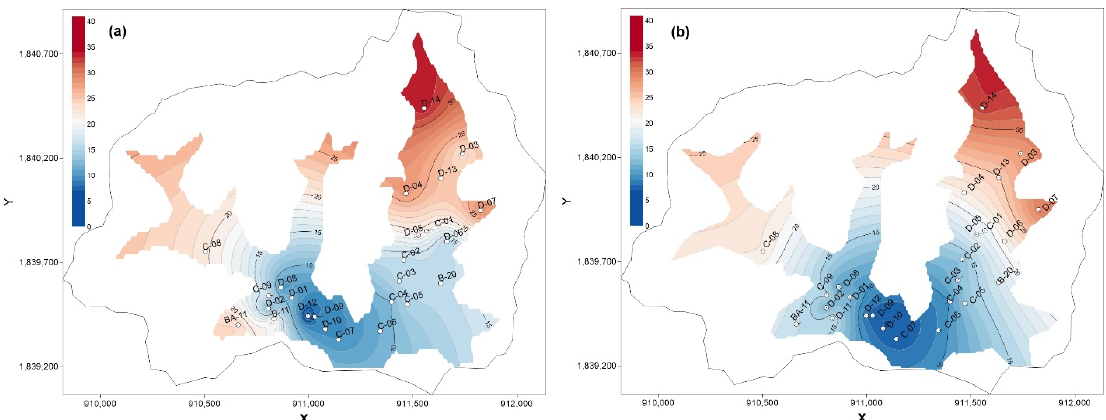
Figure 3. Spatial distribution of groundwater levels based on ( a ) the first survey in July 2019 and ( b ) the second survey in October 2019. Groundwater levels are expressed as the altitude above mean sea level.